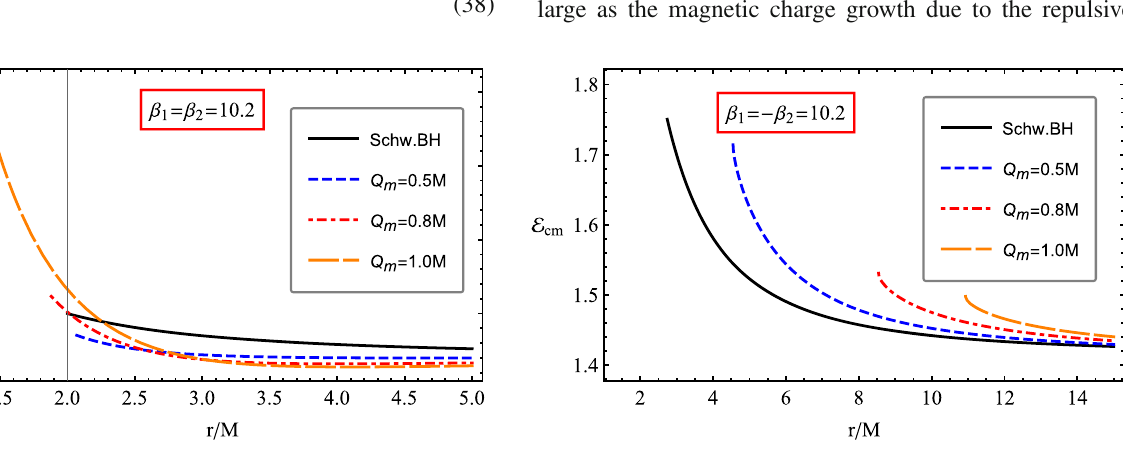
responds to the collision of two magnetized particles with the same direction of magnetic dipole moment, and the bottom one corresponds to collisions of the magnetized particles with the opposite direction of magnetic dipole